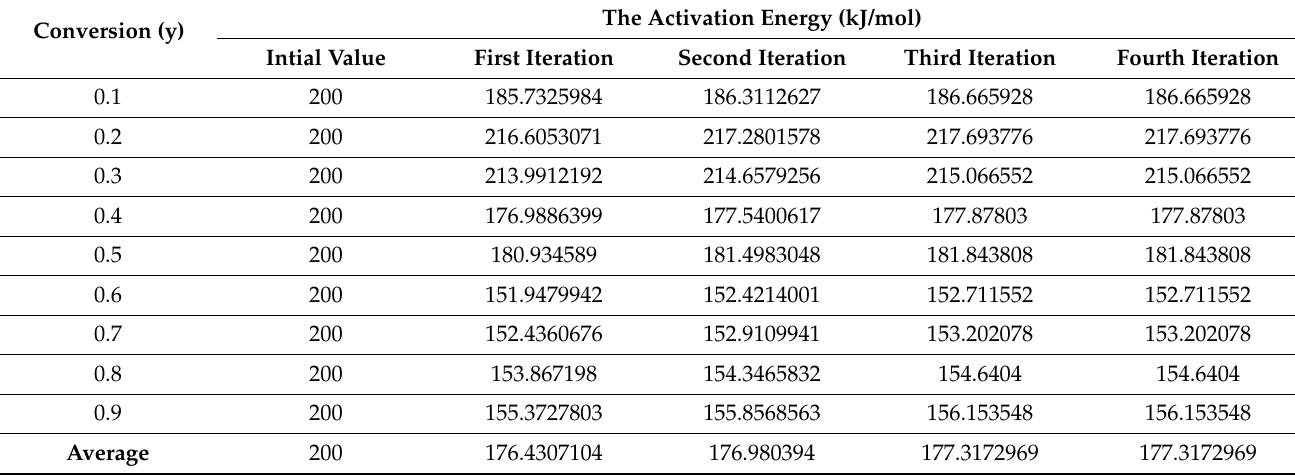
Table 6. The determined activation energy using the Vyazovkin method at different number of iterations.